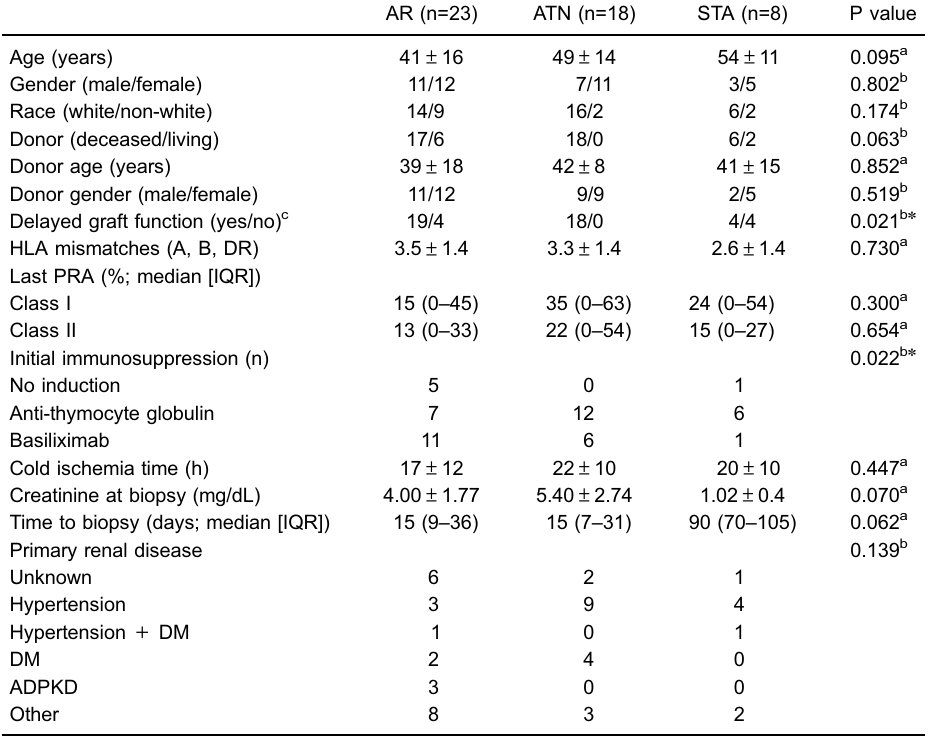
Table 1. Demographic data of the